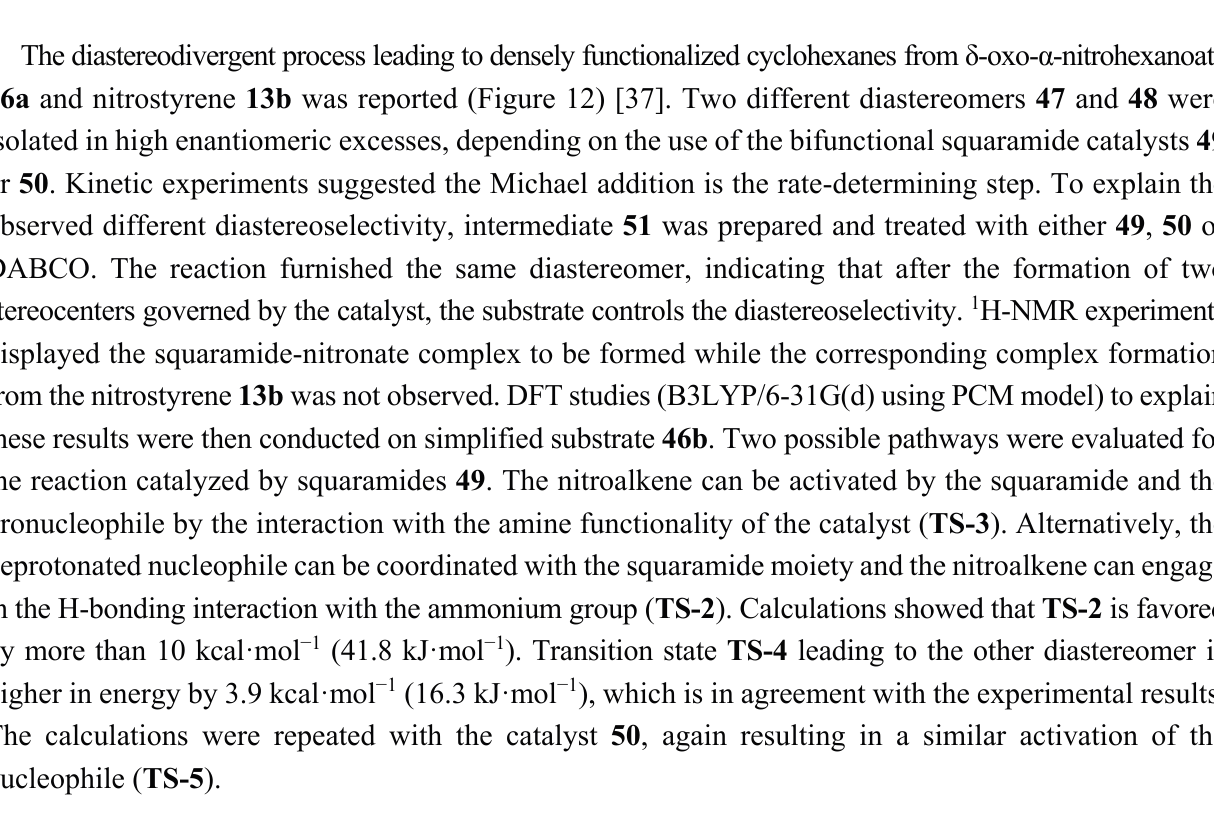
Figure 11. Dual activation mechanism TS structures of the C–C bond forming step for the addition of γ -butyrolactam 42 to chalcone 43 ( a ); proposed mechanism pathways ( b